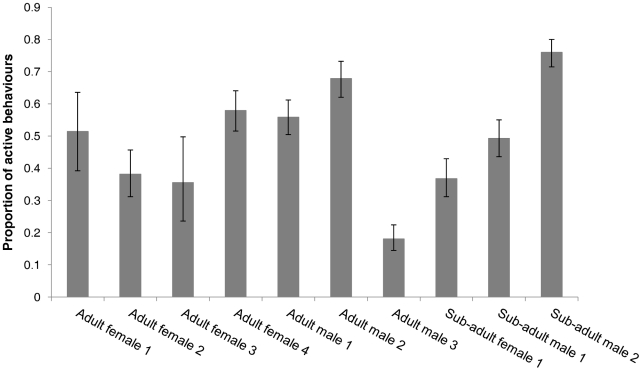
Proportion of active behaviours across individuals in the study.The standard error of the logit values were used to construct 95% confidence intervals indicated by the error bar.